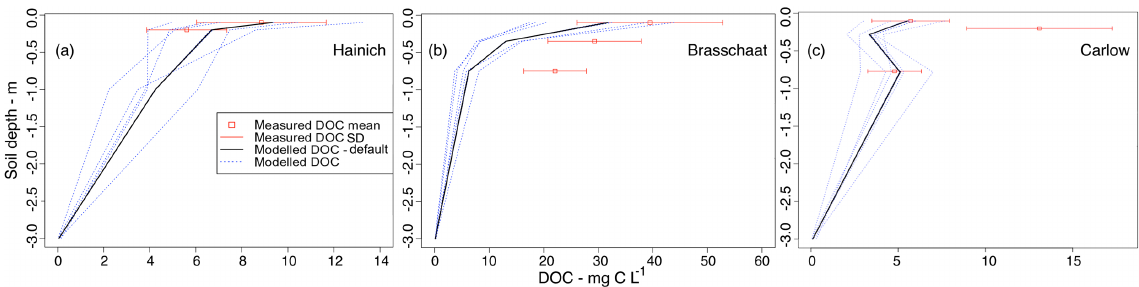
Figure 9. DOC concentration (mgCL − 1 ) in 3m of soil depth at Level 1 sites modelled (black line: default parameter set; blue dashed line: sensitivity test parameter set) versus measured (red square: mean; red line: standard deviation) for (a) Hainich, (b) Brasschaat, and (c) Carlow. Plot of each parameter in 3m of soil depth in Fig.